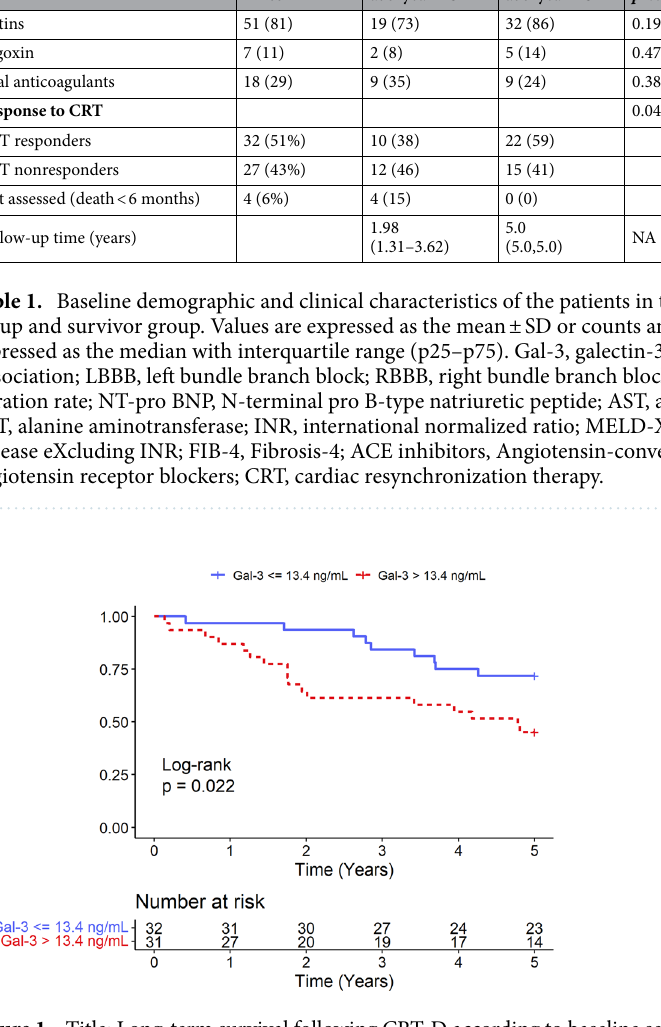
Figure 1. Title: Long-term survival following CRT-D according to baseline serum Gal-3 concentration. Kaplan–Meier survival estimates according to the baseline Gal-3 concentration dichotomized by a 13.4 ng/mL threshold. Patients with baseline Gal-3 concentrations above the median, 13.4 ng/mL, had a significantly lower probability of survival. Gal-3: galectin-3; CRT-D: cardiac resynchronization